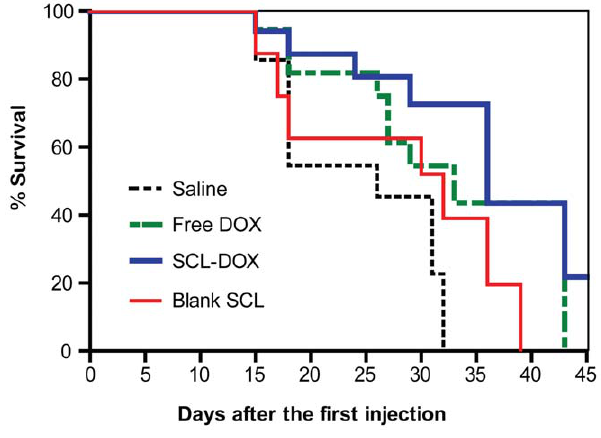
Figure 5. Sulfatide-containing liposomal doxorubicin en- hanced survival. The Kaplan-Meier survival curve shows improvement of life span of xenograft-bearing mice treated with SCL-DOX (n=9 , 10 per group). Mice were treated as indicated in Figure 3 and were sacrificed throughout the study period upon reaching our study end point.